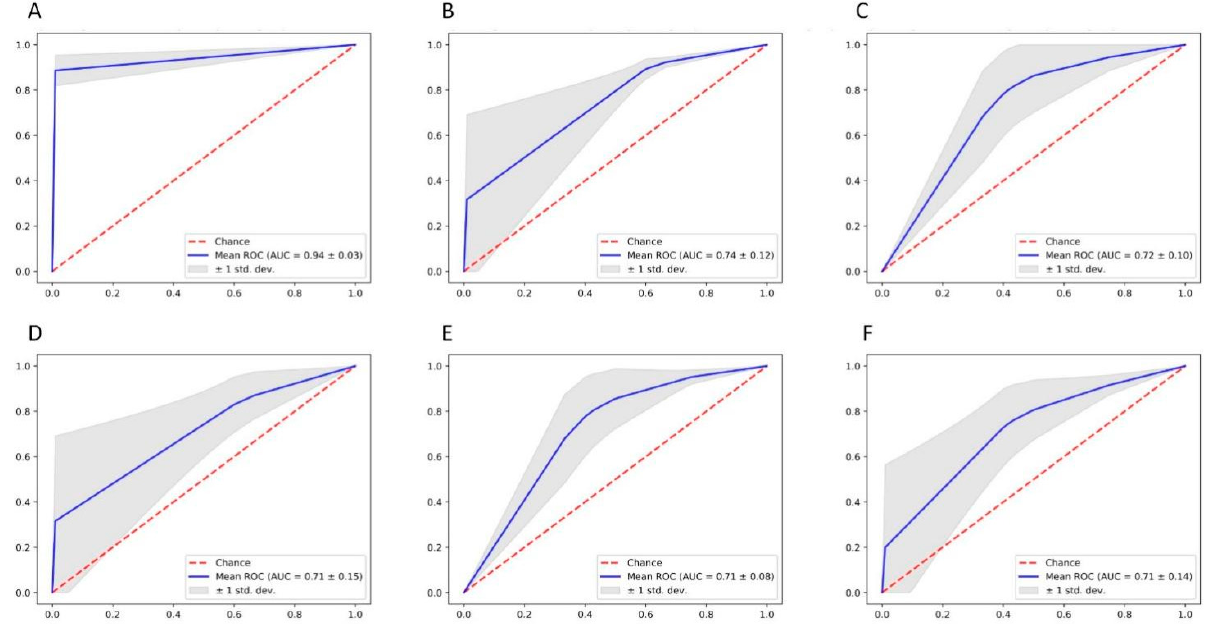
Figure 4. The ROC of confusion matrix diagnosis index in the comparison of hydrocephalus group and symptomatic group. ( A ) dilated temporal horns, dilated third ventricle, rounded posterior horns, and DESH; ( B ) ER + FHR; ( C ) FHR + CMR; ( D ) ER + FHR + CMR; ( E ) FHR + CMR; ( F )